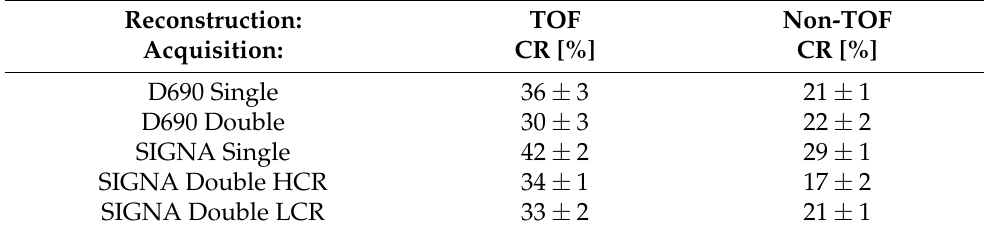
Table 5. Contrast recovery at 48 updates for the 7 mm sphere for the different acquisitions. Data reported as mean ± one standard error.